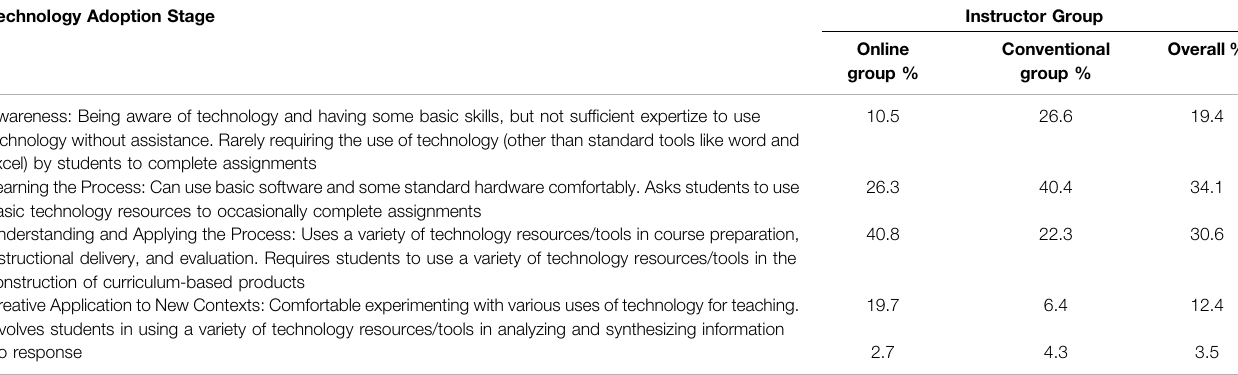
TABLE 1 | Technology adoption stage of instructors in online group, conventional group, and